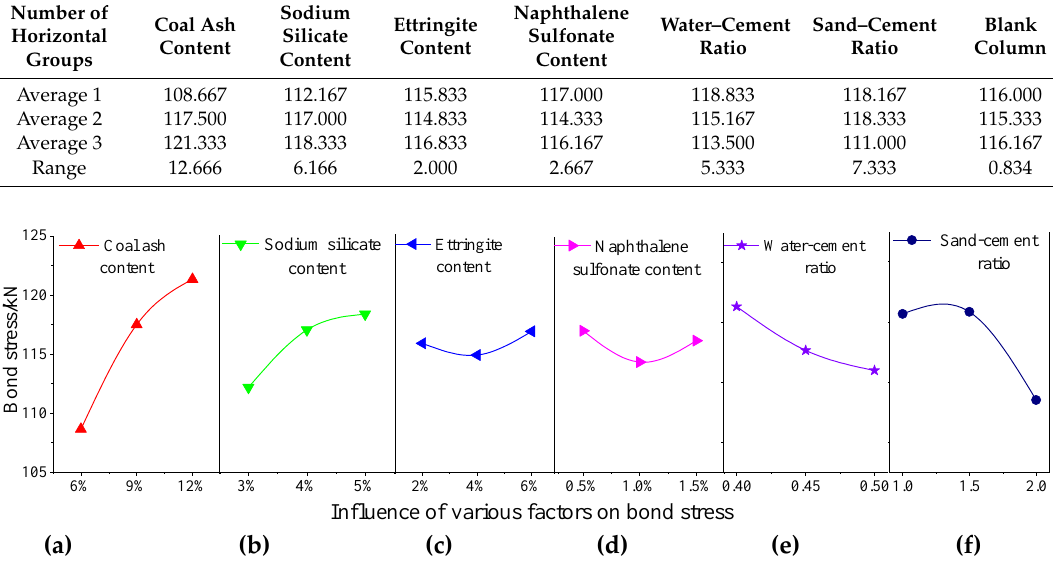
Table 6. Range analysis of bond stress.